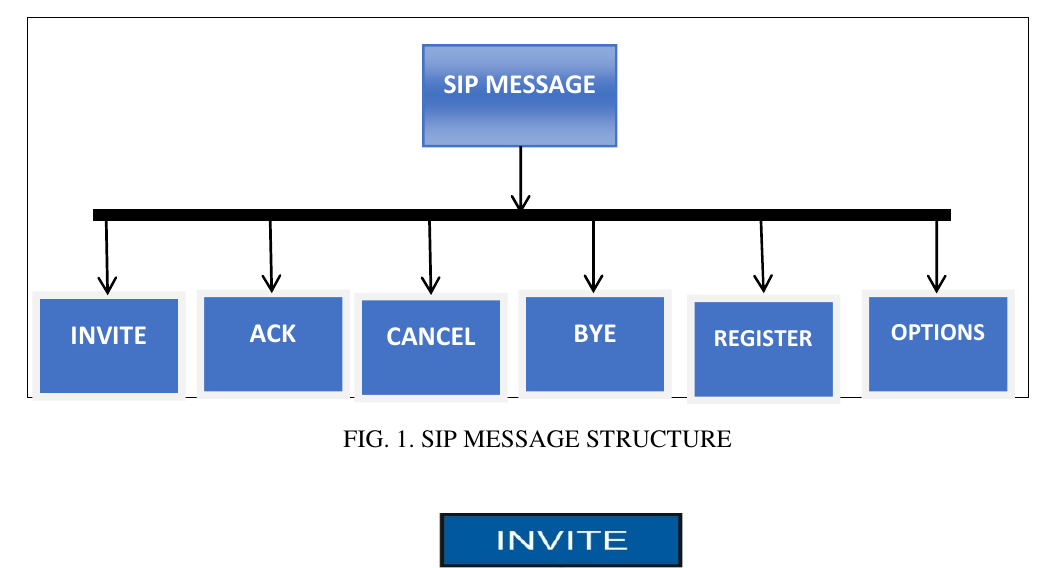
FIG. 1. SIP MESSAGE STRUCTURE